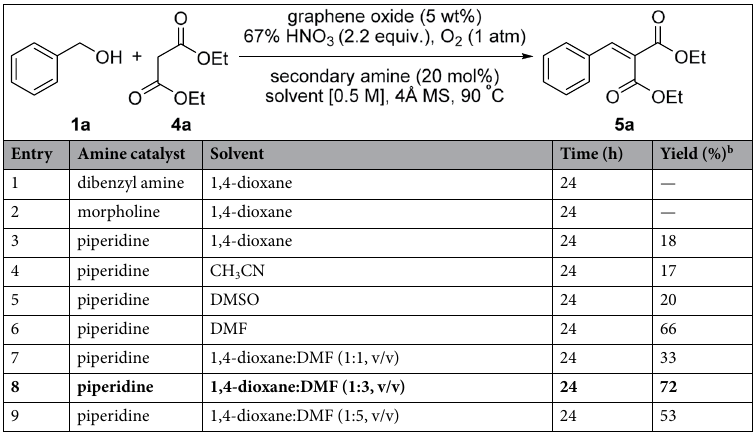
Table 2. Optimisation of a variant of the Knoevenagel condensation a . a Reaction conditions: 1a (1